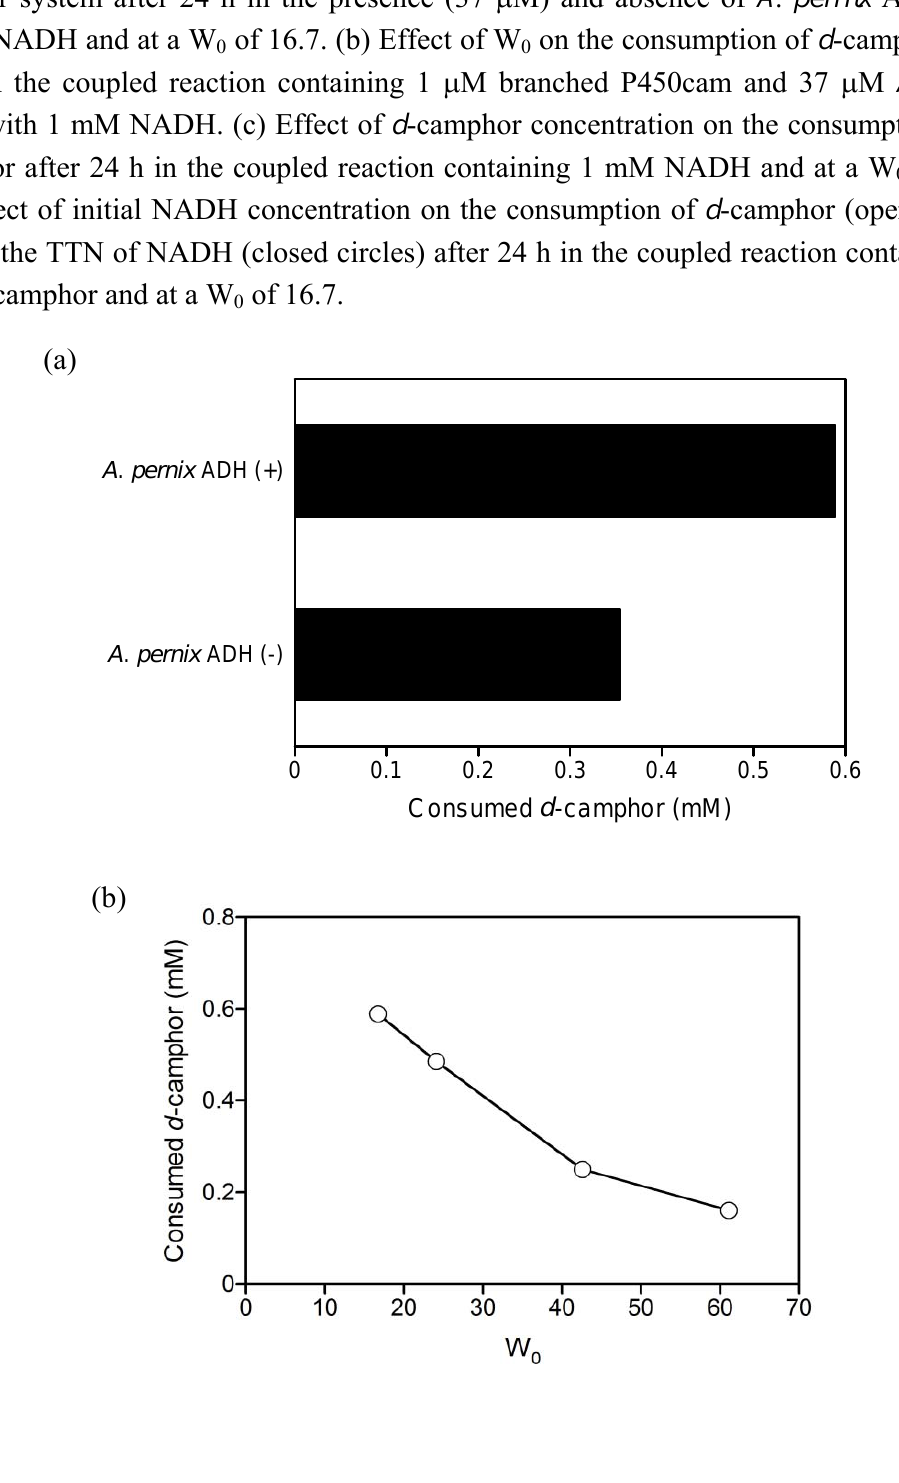
Figure 7. (a) The consumption of d -camphor by branched P450cam (1 μ M) in the reversed micellar system after 24 h in the presence (37 μ M) and absence of A . pernix ADH with 1 mM NADH and at a W of 16.7. (b) Effect of W on the consumption of d -camphor 0 0